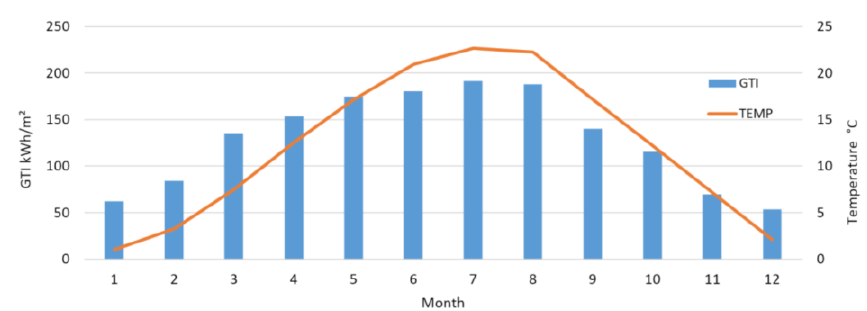
Figure 2. The average GTI and average monthly temperatures for Dragotin [24].